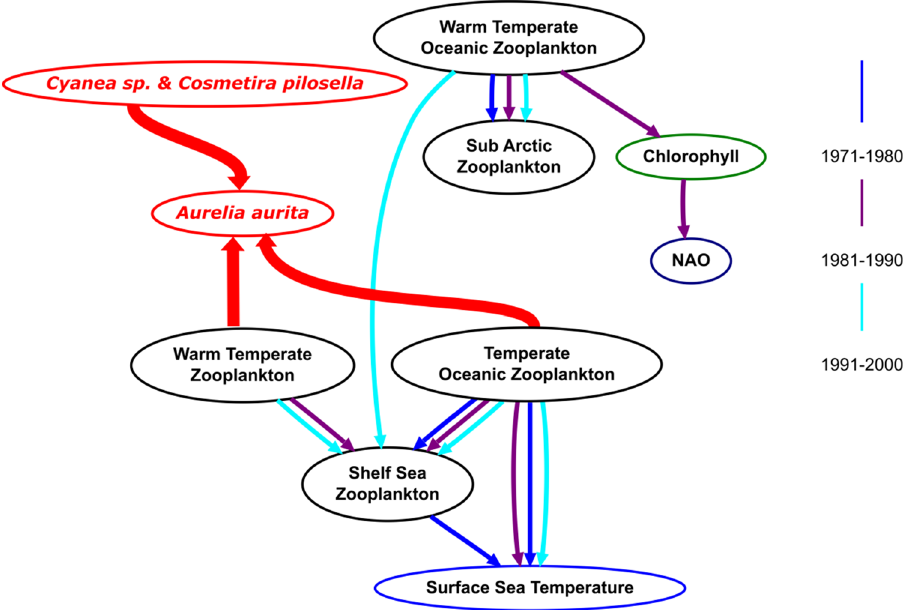
Figure 7. The network used to infer historic Aurelia abundances across the three decades (70s: purple edges, 80s: blue edges and 90s: cyan edges). The red edges and nodes were inferred from the cruise data, and are assumed to be constant over the historic study period (1971–2000). Different coloured edges represent different time